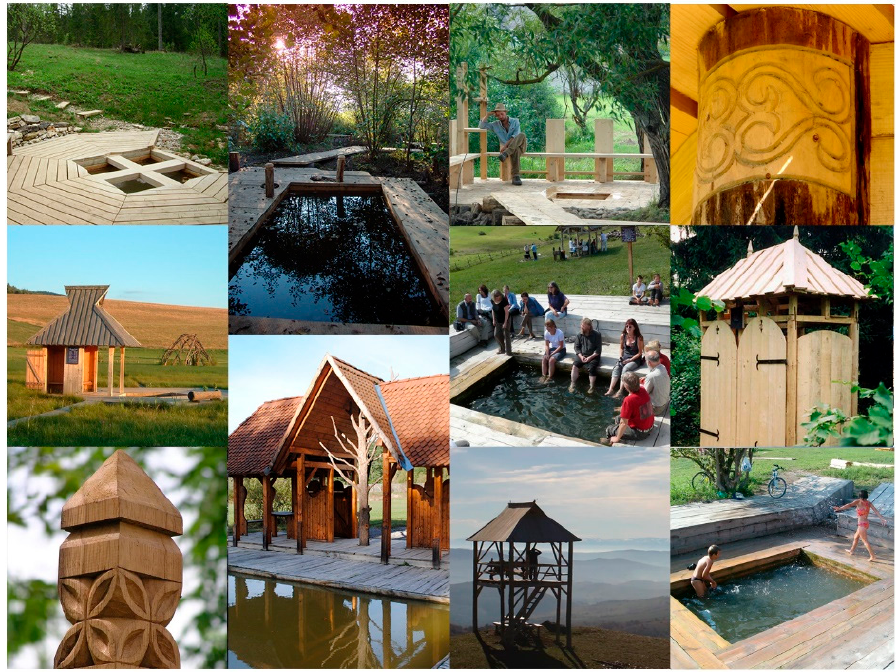
Figure 11. Detail photos of some renewed vernacular baths of community work. Source: Ars Topia Foundation.